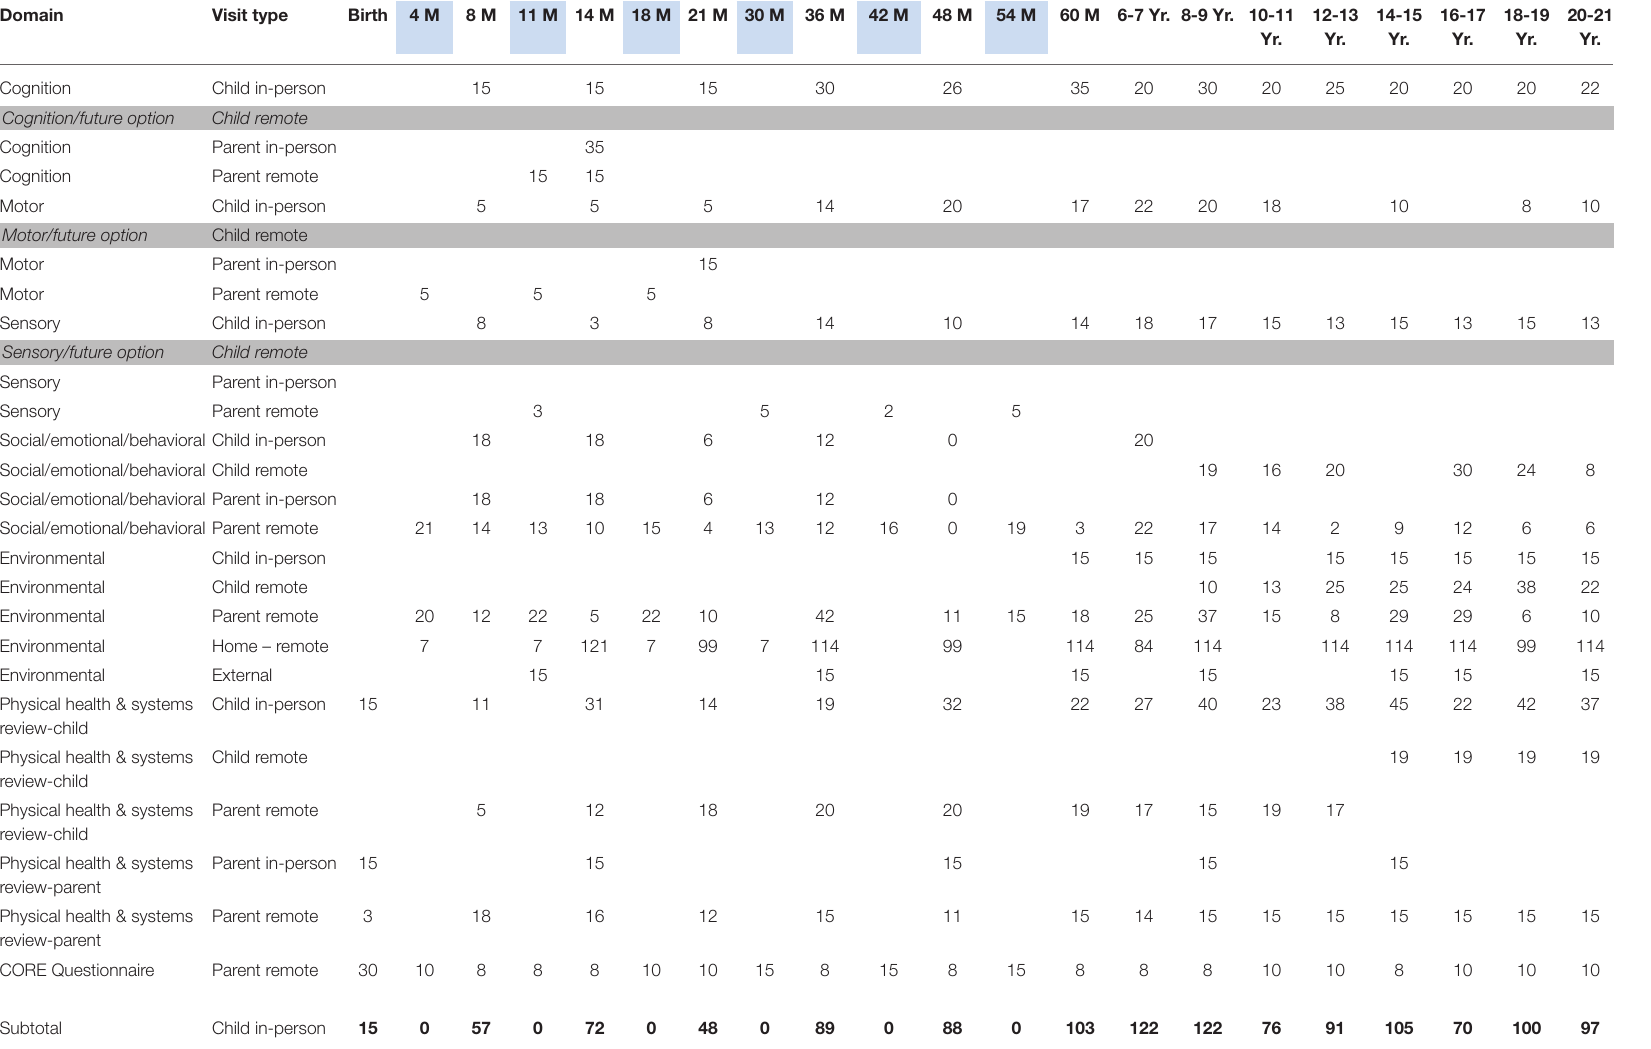
TABLE 3 | Composite visit schedule and assessments with estimated timing (in